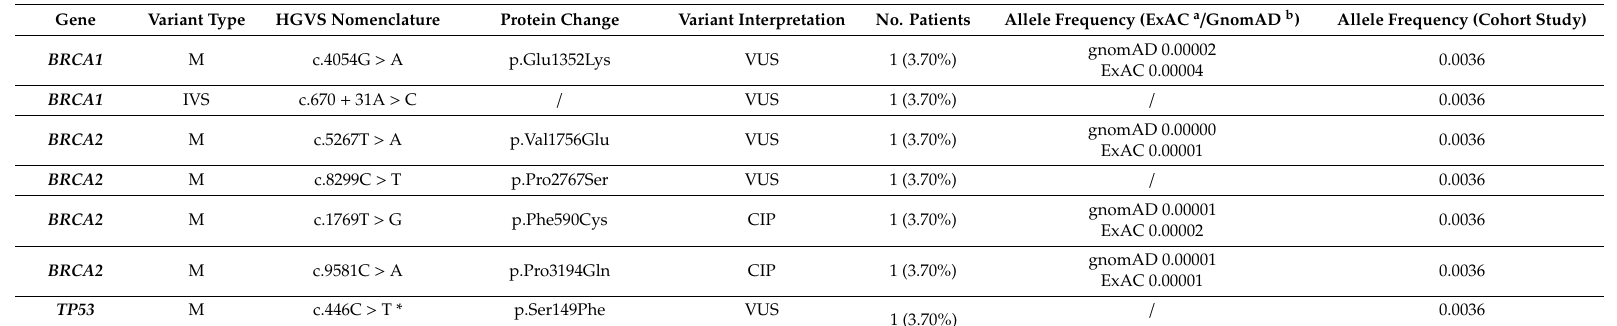
Table 4. Variant of uncertain significance detected in patients with bilateral breast